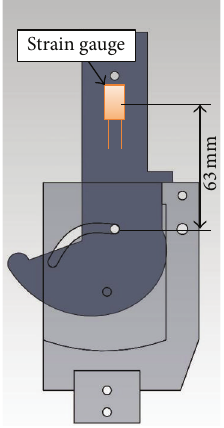
Figure 19: Position of strain gauge.